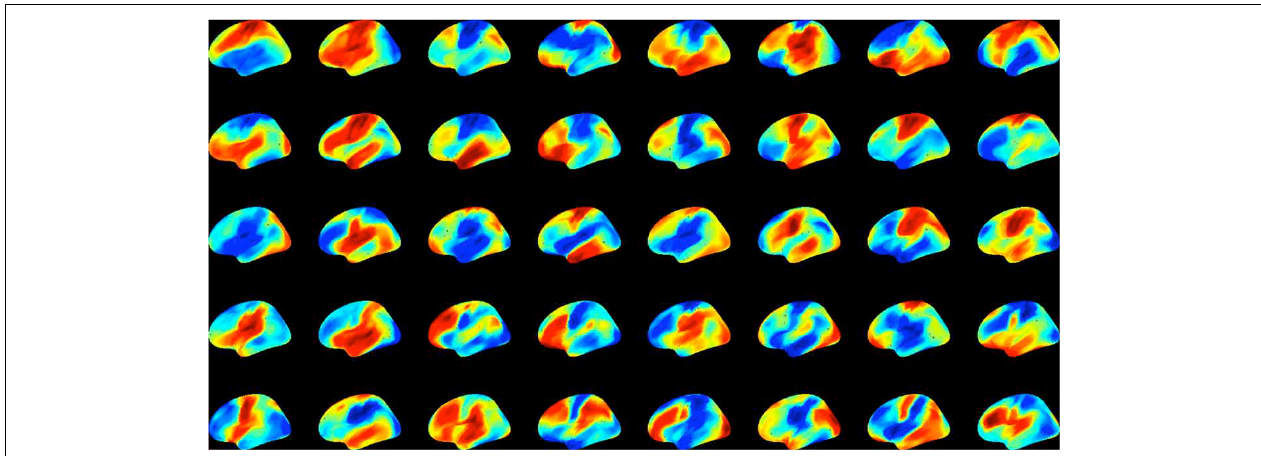
FIGURE 4 | The 40 most frequent equilibrium patterns at T = 0 activation level fromthe spin-glass model. Pseudo-color indicates the probability of UP (red) and DOWN (blue) states of each site (scale is arbitrary). Patterns were classified using hierarchical clustering at 99% similarity after 15mm spatial smoothing.